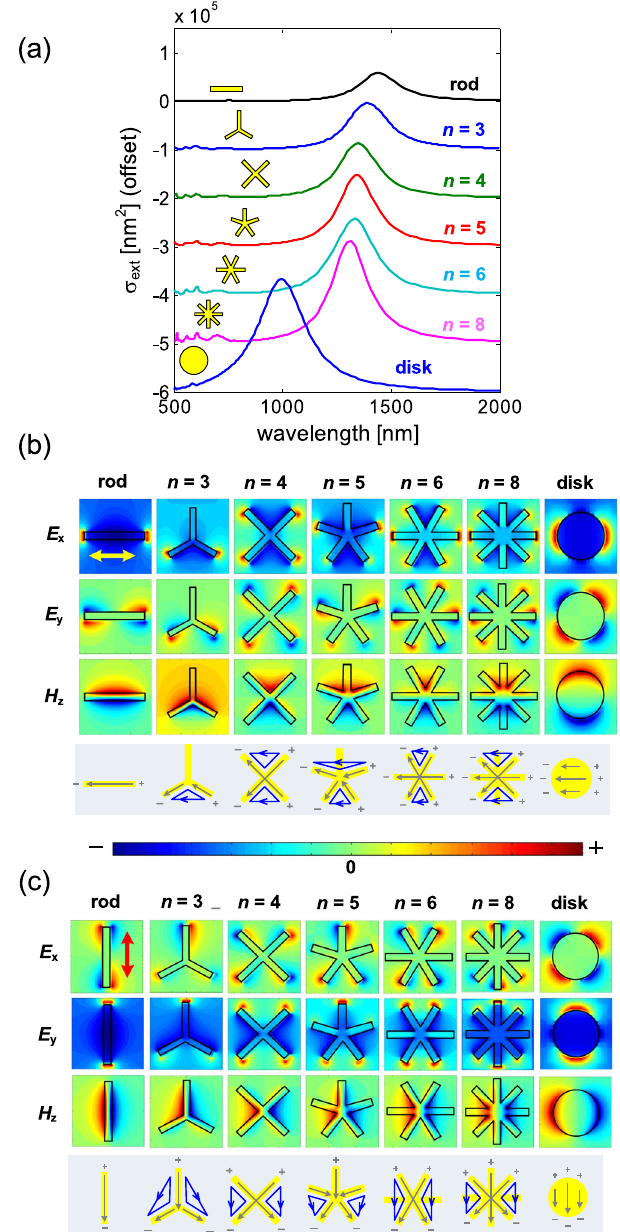
Figure 6. Evolution of modes from a nanorod, to C n structures ( n = 3–8), and finally to nanodisk under x -polarized incidence. ( a ) The extinction cross sections of a nanorod, C n structures, and nanodisk under unpolarized light illumination. The corresponding electromagnetic field distribution under ( b ) X -polarization and ( c ) Y -polarization, with the indicated circulating currents (blue), electric dipoles (gray), and incidence polarizations (double arrows). The arm length for all C n structure is s = 125